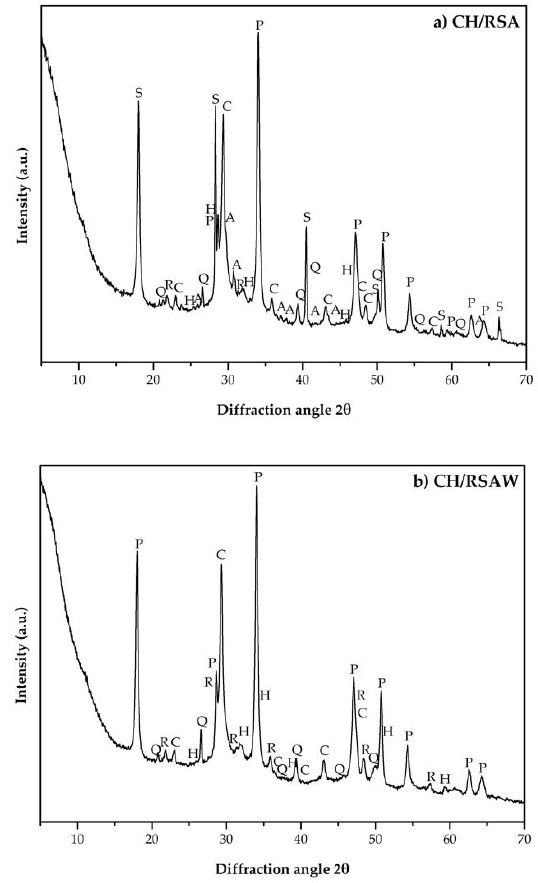
Figure 11. X-ray diffractograms of pastes 1/1 after 28 curing days: ( a ) CH/RSA; ( b ) CH/RSAW.